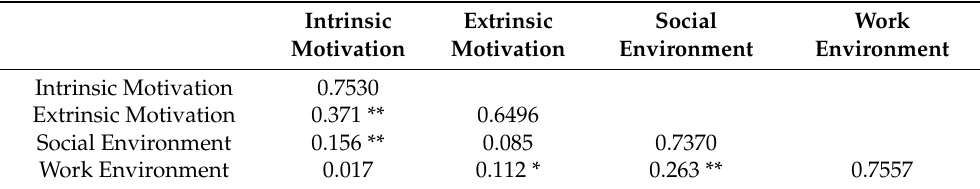
Table 6. The square root values of average variance